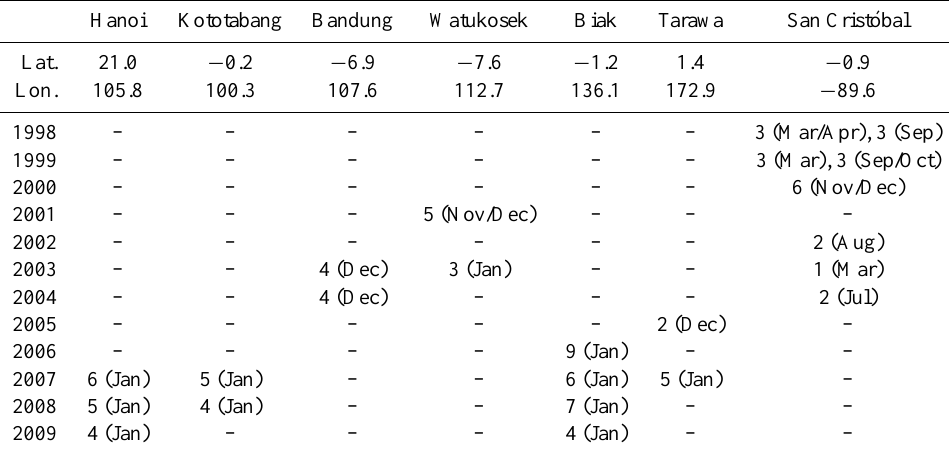
Table 1. Summary of water vapour sonde observations during each campaign. Only those with NOAA Frostpoint Hygrometer (FPH) and Cryogenic Frostpoint Hygrometer (CFH) are shown. See Fig. 1 for geographical location.